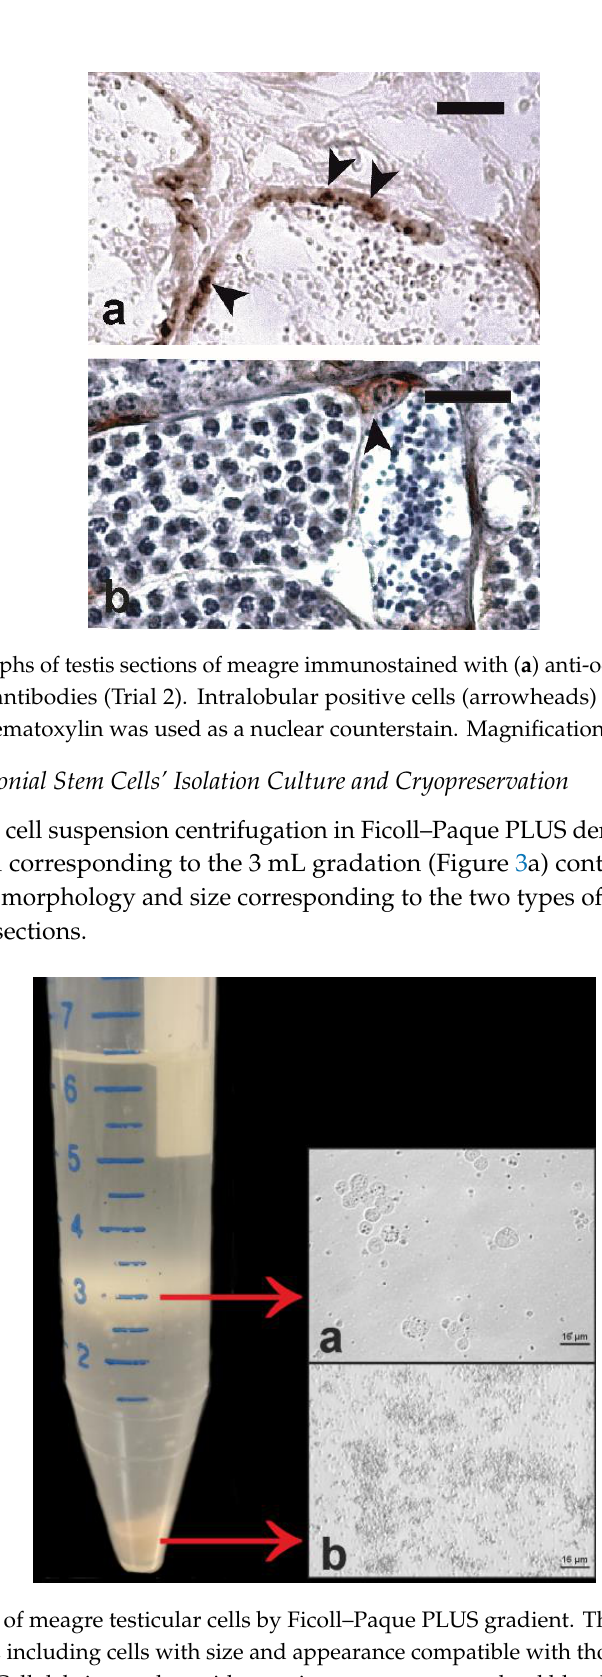
Figure 3. Isolation of meagre testicular cells by Ficoll–Paque PLUS gradient. The band ( a ) contained di ff erent cell types, including cells with size and appearance compatible with those of spermatogonial stem cells (SSCs). Cell debris together with putative spermatozoa and red blood cells were present in the pellet ( b